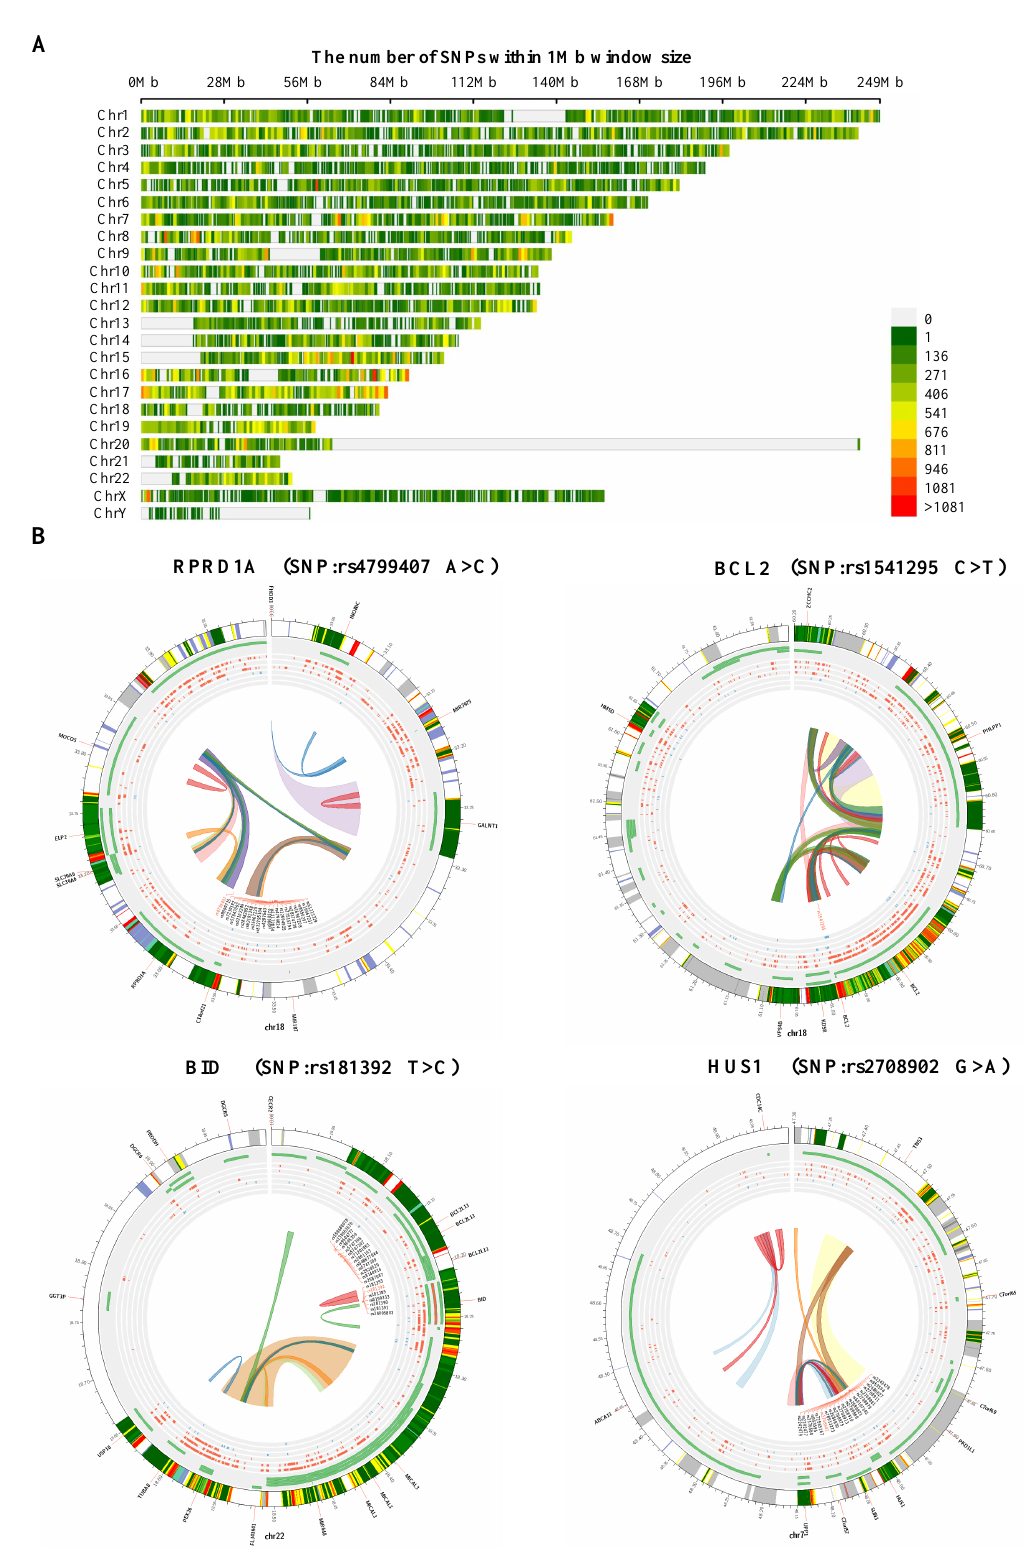
Figure 5. The analysis of DE-mRNAs-associated SNPs. ( A ) Chromosome distribution of SNPs within 1 Mb window size. ( B ) The top 4 genetic polymorphisms (rs4799407, rs1541295, rs181392, and rs2708902) are shown in the Circos plots. From outer to inner, the circles represent chromatin states, annotated genes (green), histone modification set (red), transcription factor set (blue), current variant and associated variants, and 3D chromatin